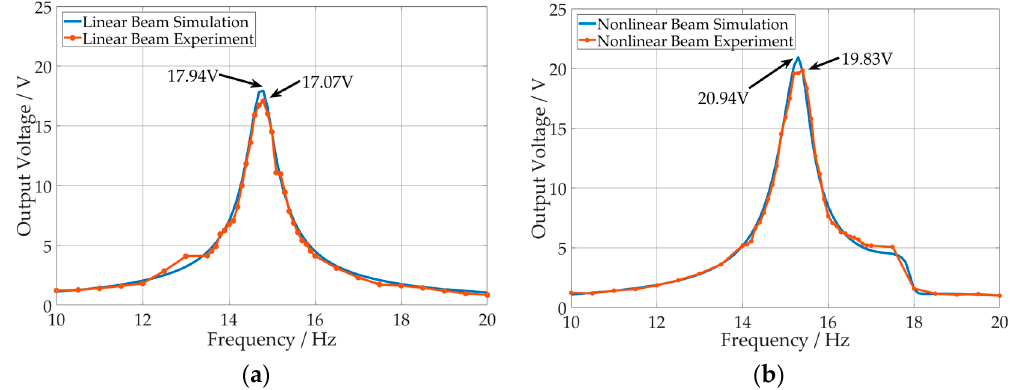
Figure 10. Optimal output voltage: ( a ) Linear configuration; ( b ) Magnetic coupled configuration.